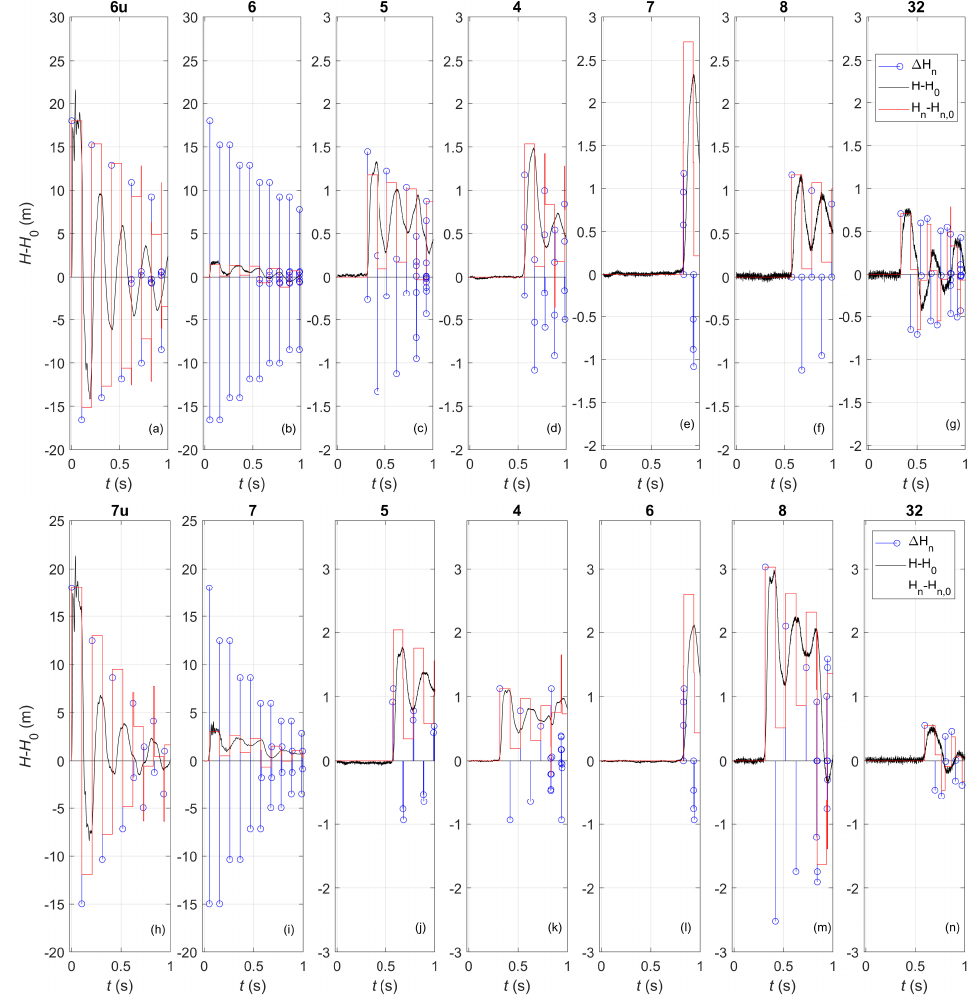
Figure 7. Tests #2, and #3—experimental pressure disturbances, H − H 0 , vs. the impulse response function, ∆ H n , (blue stems) and numerical reconstruction, H n − H n ,0 , (red line) carried out by the Lagrangian model (LM) at measurement sections: ( a ) 6u; ( b ) 6; ( c ) 5; ( d ) 4; ( e ) 7; ( f ) 8; and ( g ) 32, for test #2, and ( h ) 7u; ( i ) 7; ( j ) 5; ( k ) 4; ( l ) 6; ( m ) 8; and ( n ) 32, for test